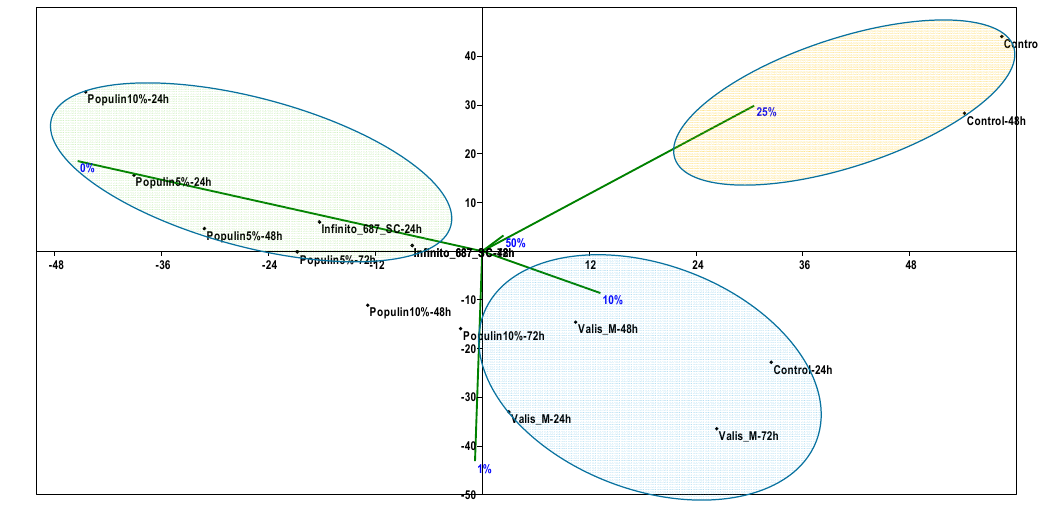
Figure 4. Principal Components Analyses (PCAs) showing the e ff ect of either populin, synthetic fungicide or its absences (control) as environmental variables to late blight strain M16 infection rate under field conditions. The green color represents the PCA axis direction of the populin e ff ect, the blue color represents PCA the axis direction of the Valis e ff ects and the yellow color represents the PCA axis direction of the control e ff ects.